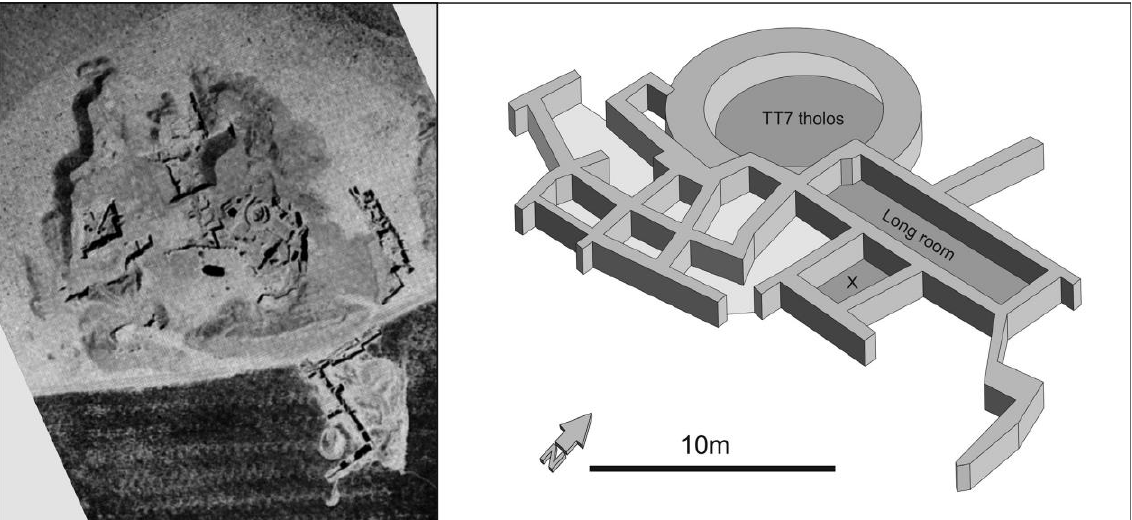
Figure 6. Left: air photograph of Arpachiyah during excavation; the TT7 tholos underlying the Burnt House is visible at the centre right (RAF photo. Original in British Museum). Right: isometric reconstruction of the TT6 Burnt House indicating the long room where most of the obsidian was